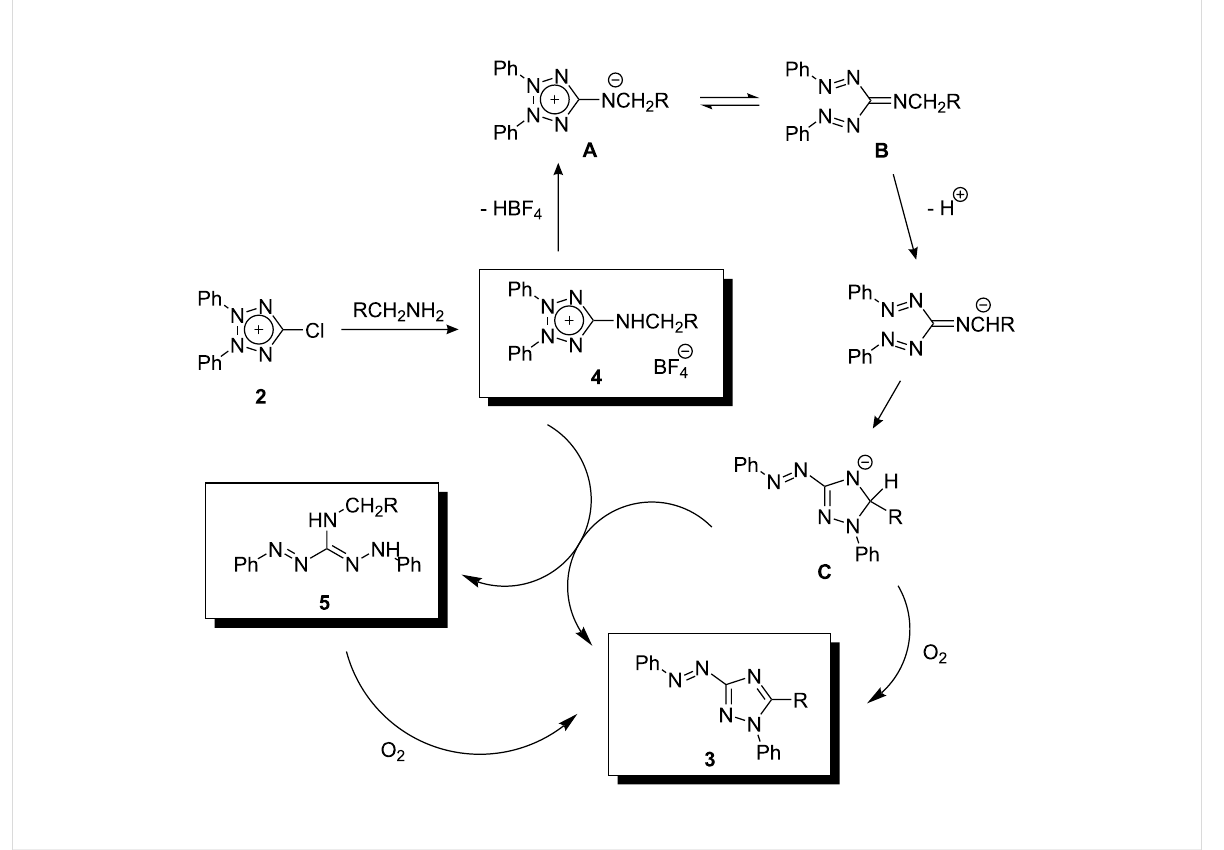
Scheme 5: Plausible reaction mechanism for the formation of 1,2,4-triazole 3